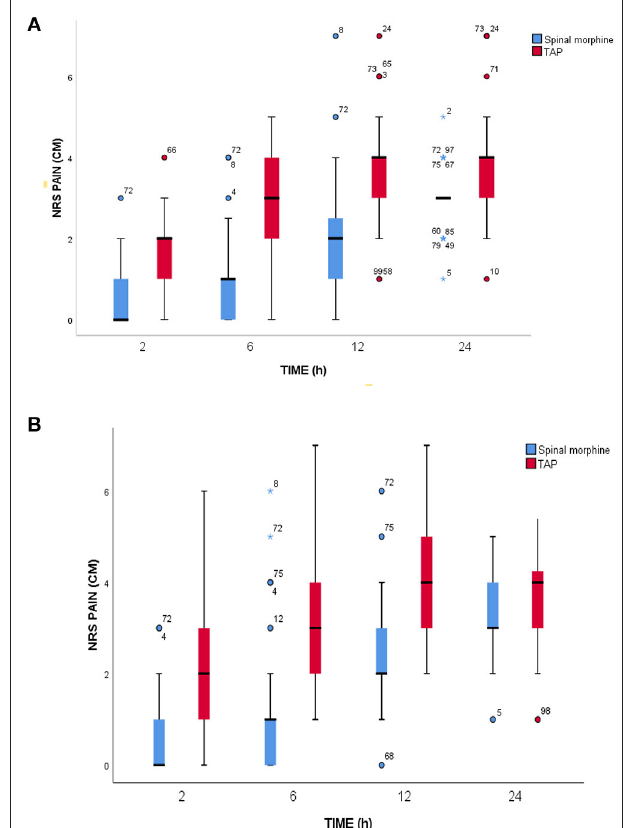
FIGURE 3 | Postoperative pain scores. (A) At rest. (B) During movement at a different time point during the 24-h assessment period. SM, spinal morphine; TAP block, transversus abdominis plane block; NRS, numerical rating score; cm, centimeter; IQR, interquartile range. The horizontal line indicates median, and hinges indicate first and third quartiles. Whiskers extend to the largest and smallest values not more than 1.5 × IQR. Outlier data points beyond the end of the whiskers are plotted as individual dots, and numbers in outlier data represent the serial number of individual data.